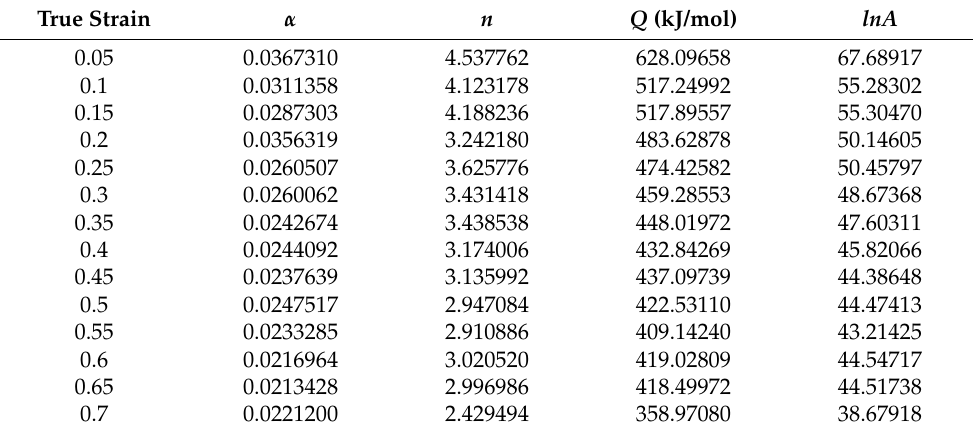
Table 2. Calculation results of α , n, Q , and lnA , when the true strain is in the range of 0.05–0.70.